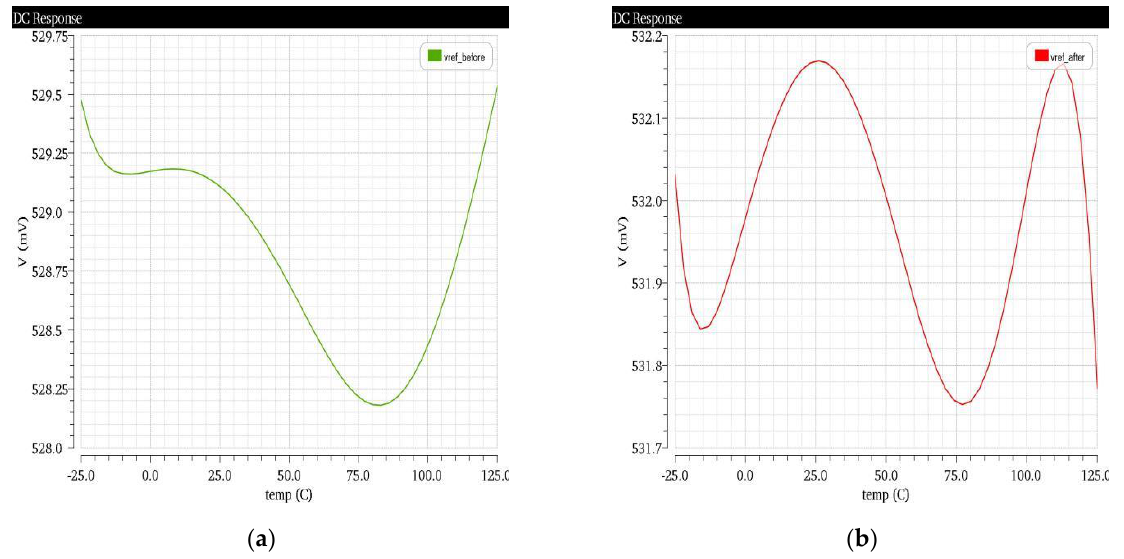
Figure 8. In reference 2 ( a ) V-T curve after first-order temperature compensation; ( b ) V-T curve after high-order tempera- ture compensation.